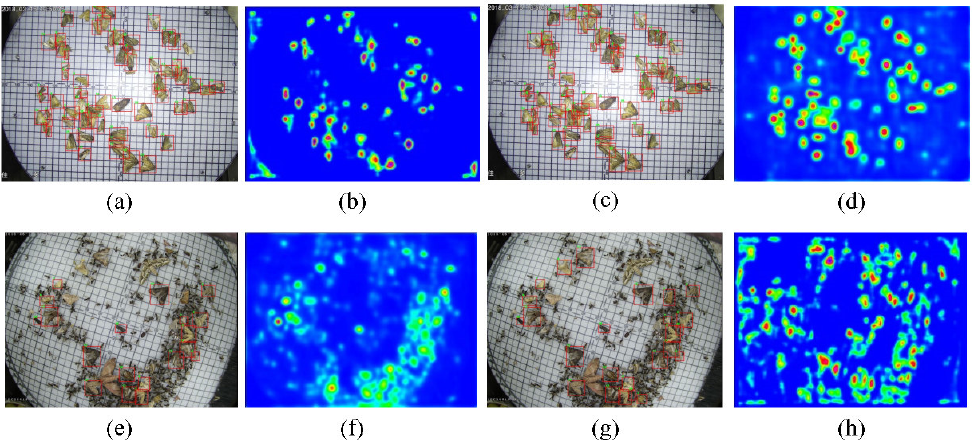
Figure 9. Visualization of detection results of different methods. ( a , b ) Results of the SSD method; ( c , d ) results of the proposed MCPD-net method; ( e , f ) results of the SSD method; ( g , h ) results of the proposed MCPD-net